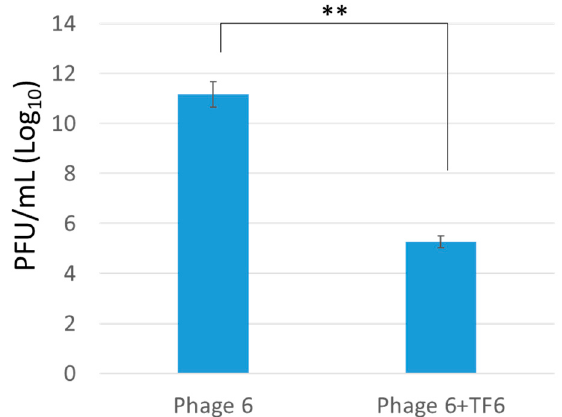
Figure 4. Phage propagation test on exopolysaccharide (EPS)-degraded bacteria. Here, the figure shows the comparison for phage propagation efficiency test in control bacterial host and tail fiber-treated bacteria. The tail fiber treated bacteria significantly reduced phage propagation efficiency.